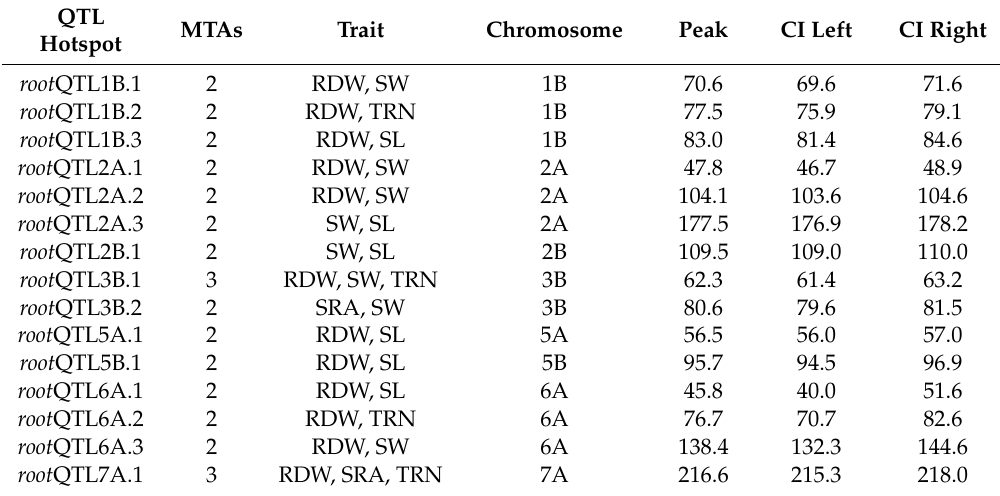
Table 5. Root QTL hotspots. Positions are indicated in cm.